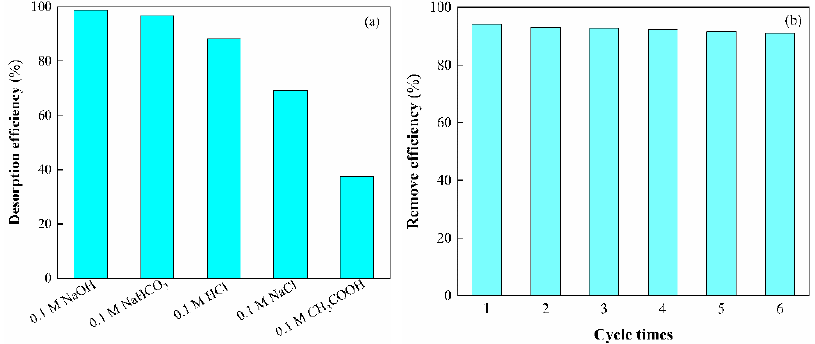
Figure 14. ( a ) Effect of type of desorption solvent on the desorption rate. ( b ) The reusability of CS-modified Dt for removal of As( Ⅴ ) ions.